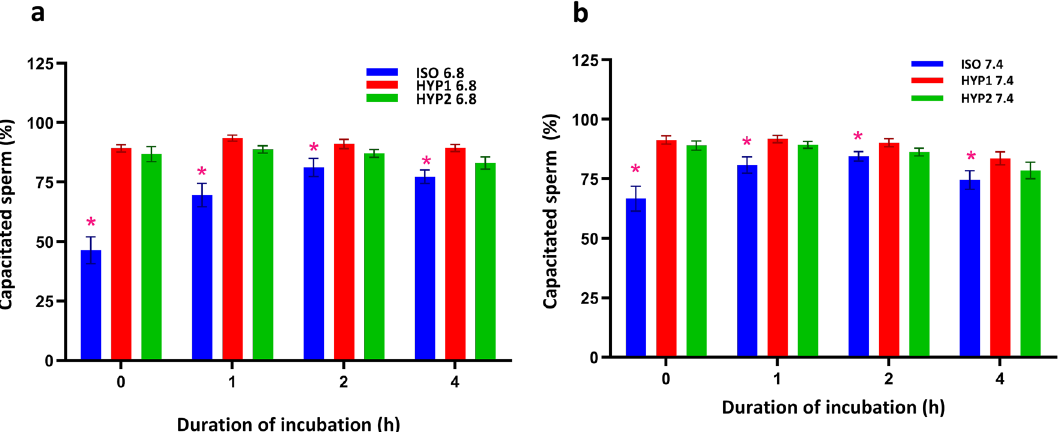
Figure 3. Effect of osmolality and pH on capacitation status in bovine sperm incubated in vitro. The hyperosmotic (HYP1) uterine ( a ) and oviductal ( b ) environment significantly ( p < 0.05) increased capacitation of sperm. The interaction of pH with osmolality and incubation time was significant ( p < 0.05) for capacitation status. *represent the effects of osmolality, differ significantly ( p < 0.05) at a particular time point. (ISO: 290 mOsm/kg; HYP1: 355 mOsm/kg; HYP2: 420 mOsm/kg; BI: Before incubation).